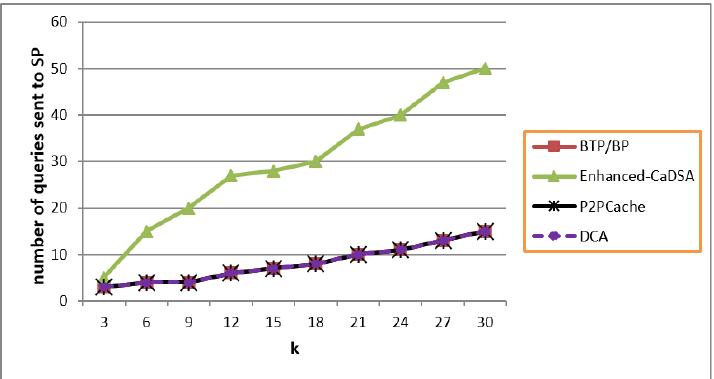
Figure 17. Communication